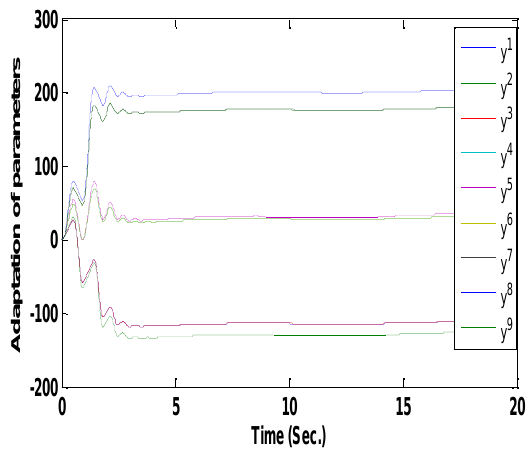
Figure 6. Adaptation of parameters.